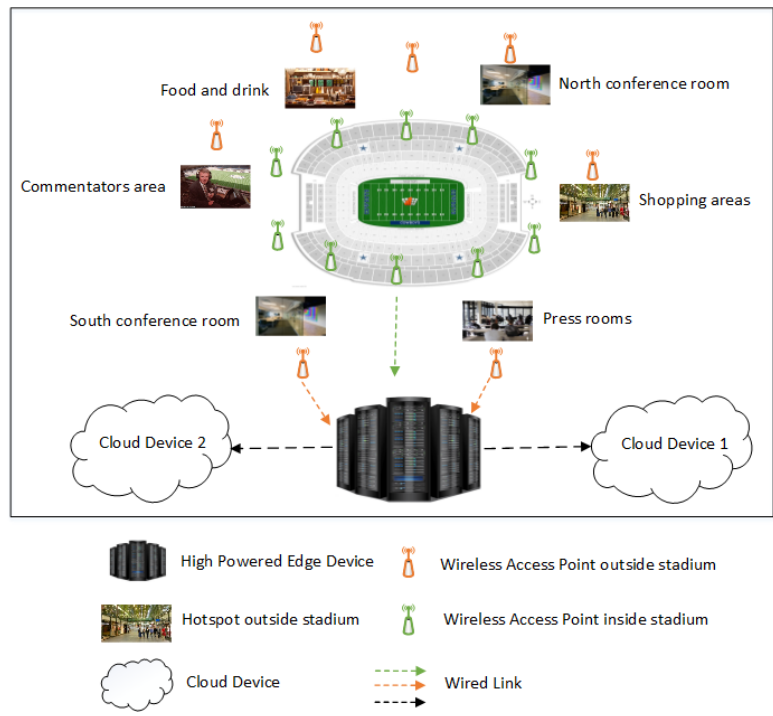
Figure 2. Example of the communication scenario in a